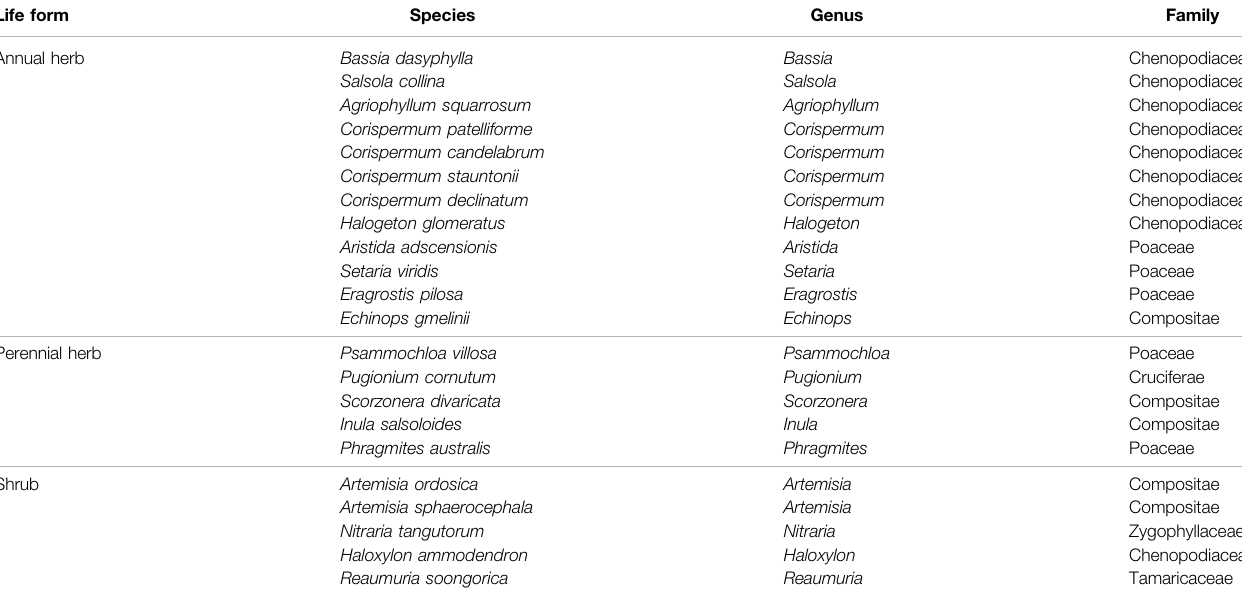
TABLE 1 | Vegetation species composition in the study area.